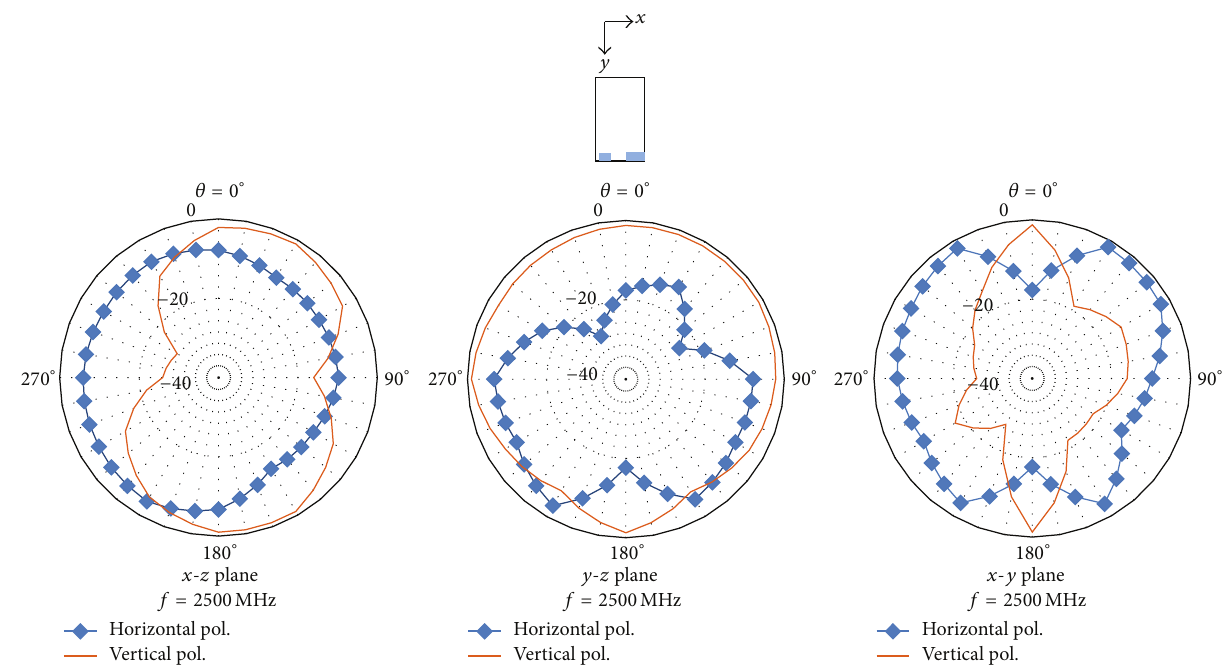
Figure 11: Radiation pattern of the proposed antenna at 2500